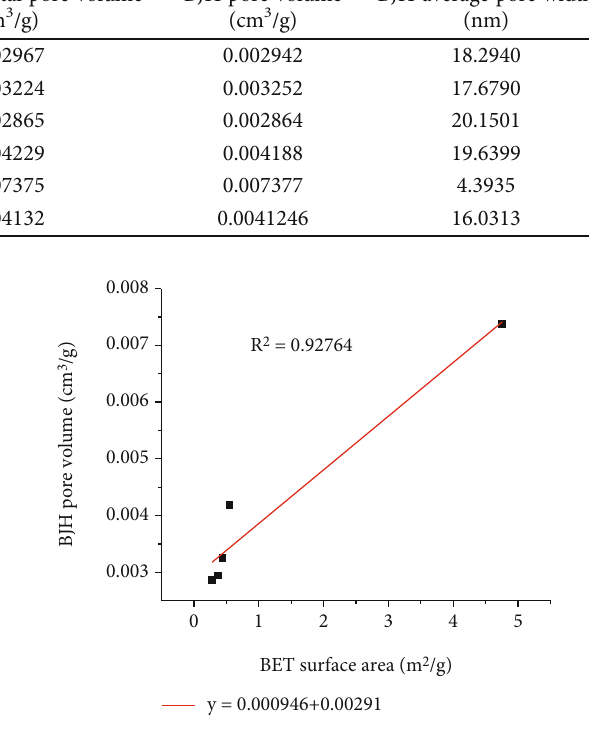
Figure 6: BET speci fi c surface area and BJH pore volume fi tting